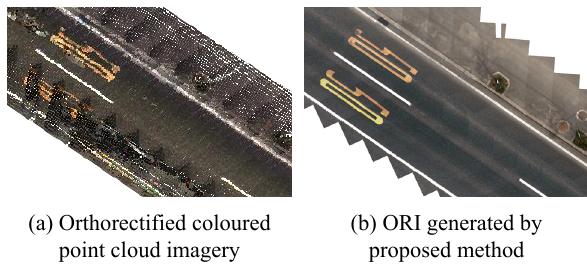
Figure 11. Comparison of